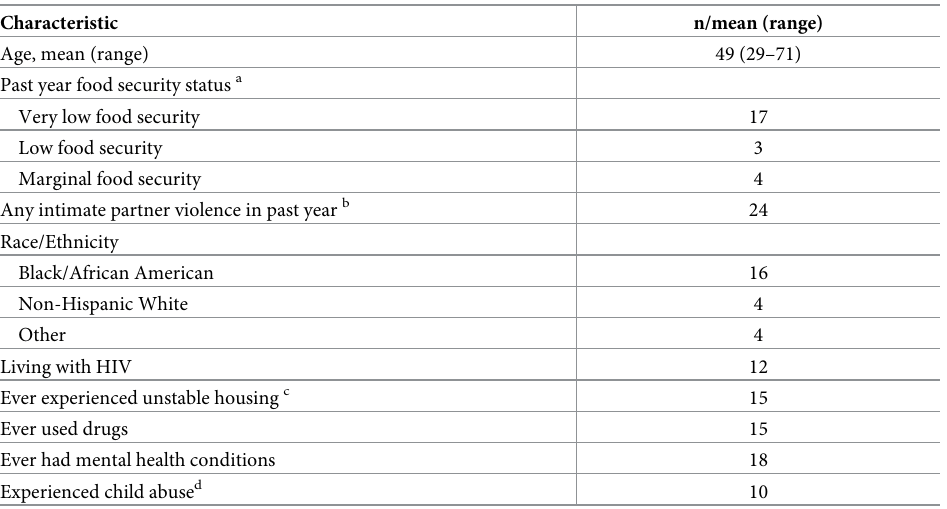
Table 1. Participant characteristics (n = 24).